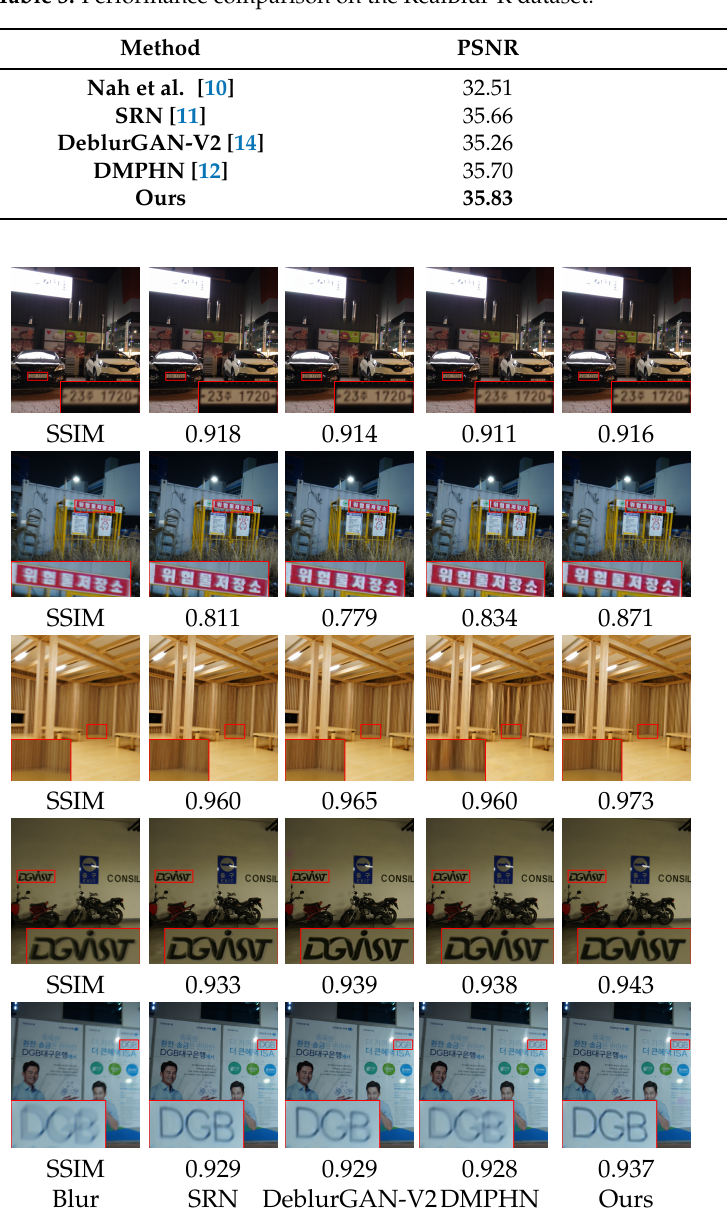
Figure 6. Visual comparisons with state-of-the-art methods on example real-word blurry images. Quantitative metric SSIM is reported below each